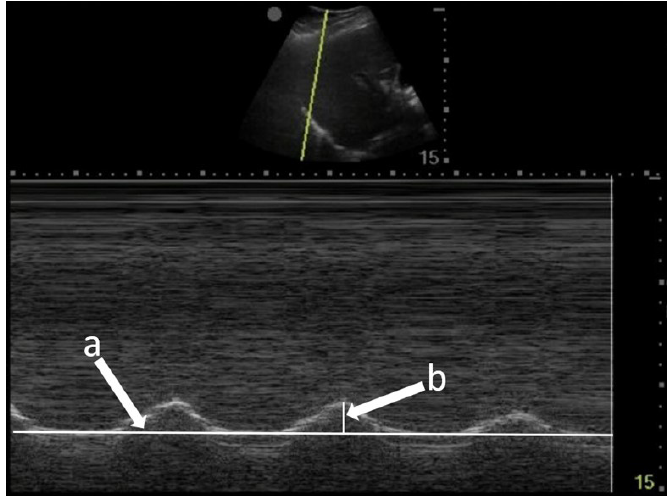
Image 1. Diaphragmatic excursion is calculated by first determining a baseline (line a) and then measuring the distance of maximal vertical excursion (distance